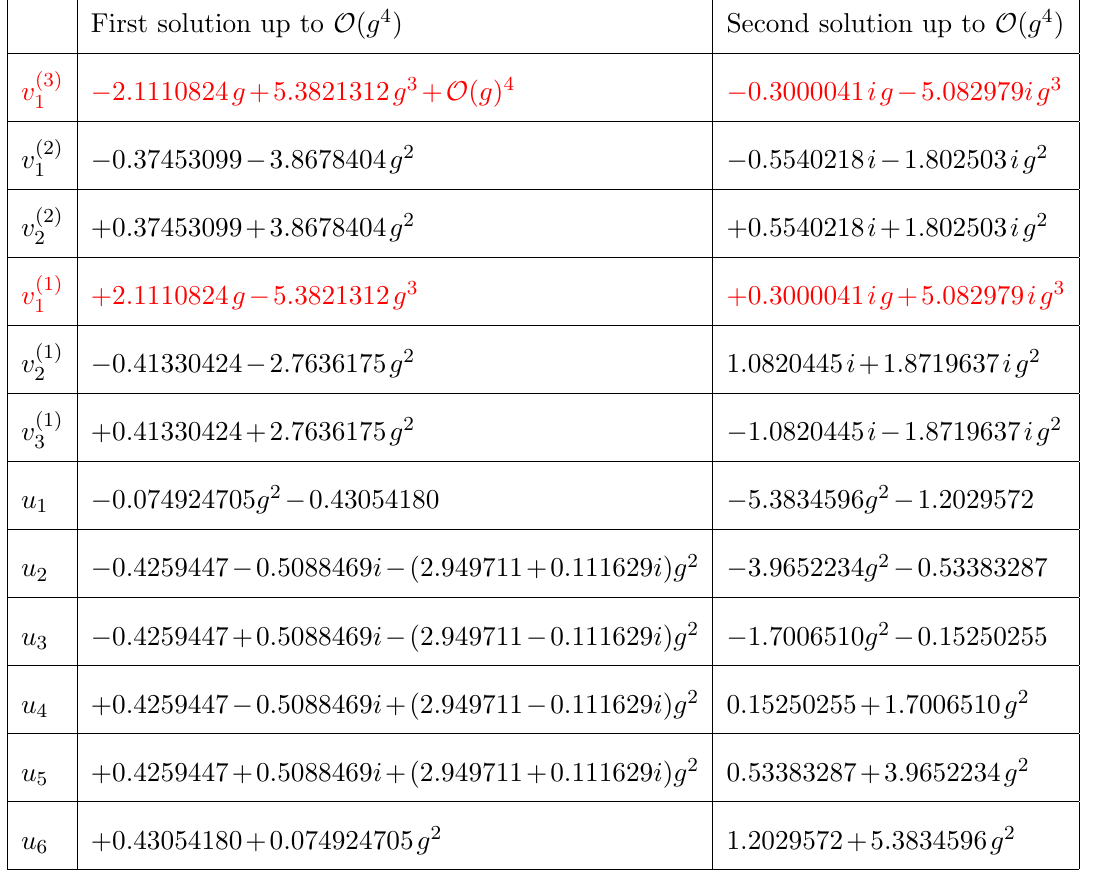
( g 0 ) and have an unusual expansion in odd powers O ( g 4 ) order for all the roots O